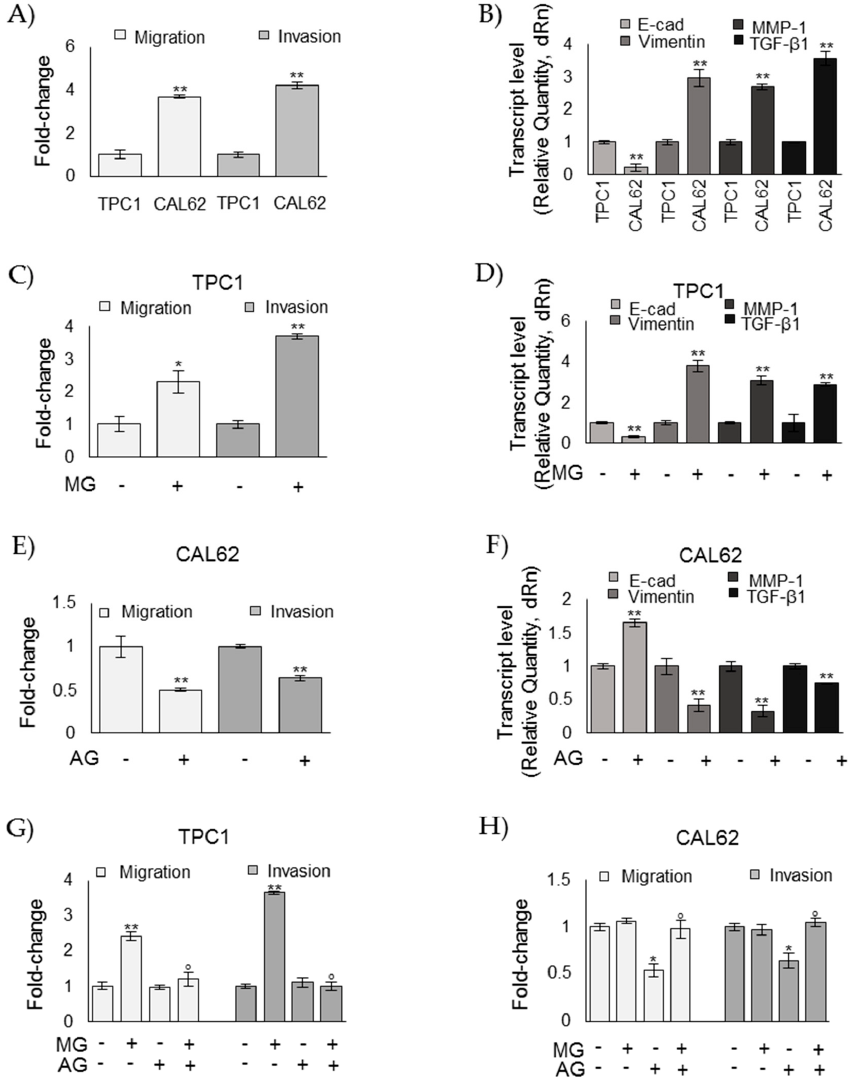
Figure 4. Methylglyoxal (MG) sustains the aggressive phenotype of ATC CAL62 cells. Papillary thyroid cancer (BCPAP and TPC1) and anaplastic thyroid cancer (8505C and CAL62) cells grown to confluence under standard conditions were analyzed by specific assays or real-time PCR to evaluate their migration and invasion capabilities ( A , C , E , G , H ) or the mRNA expression of E-cadherin (E-cad), Vimentin, MMP-1, and TGF- β 1 ( B , D , F ), respectively, as described in the Materials and Methods section. The histograms indicate mean ± SD of three different cultures, and each was tested in triplicate. mRNA expression levels were normalized to the amount of an internal control transcript ( β -actin). Invasion/migration capabilities as well as gene expression were measured in TPC1 after 5 μ M MG administration and in CAL62 cells after 1 mM aminoguanidine (AG), both for 48 h. Invasion/migration were also evaluated after MG and AG cotreatment ( G , H ) at the concentrations above reported. The histogram indicates mean ± SD of three different cultures, and each was tested in triplicate. * p < 0.05; ** p < 0.01 compared to untreated cells; ° p < 0.01 compared with MG ( G ) or AG ( H ) exposure alone.